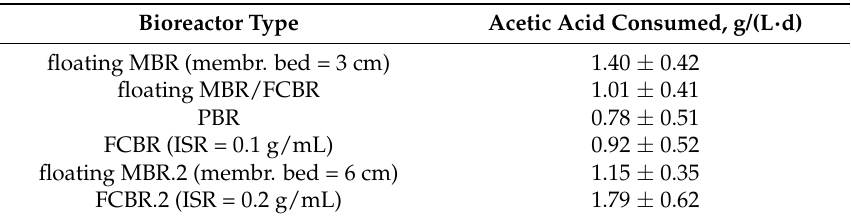
Table 1. Consumption of acetic acid in the